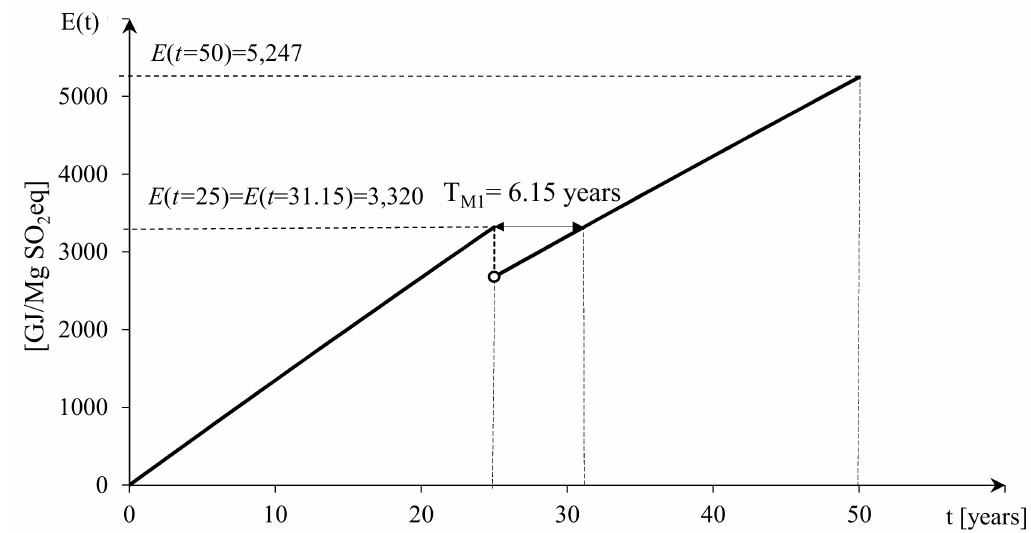
Figure 6. A graphical interpretation of the integrated ecological e ffi ciency indicator from SO 2 emissions for a wind power plant undergoing modernization during a 50-year period of use.